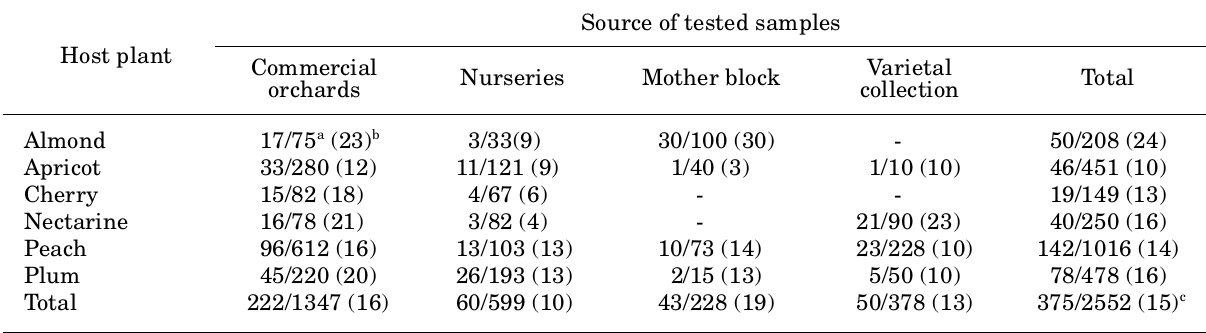
Table 1. Incidence of PNRSV in stone fruit trees/seedlings, surveyed in Jordan irrespective of location, in commer- cial orchards, nurseries, a mother block, and a varietal collection during 2000–2002 using DAS-ELISA.